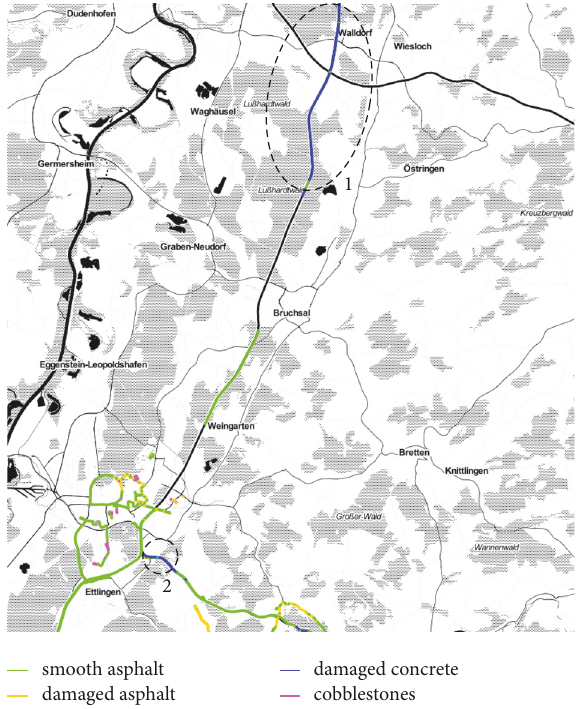
Figure 9: Material classification of an aged concrete highway.